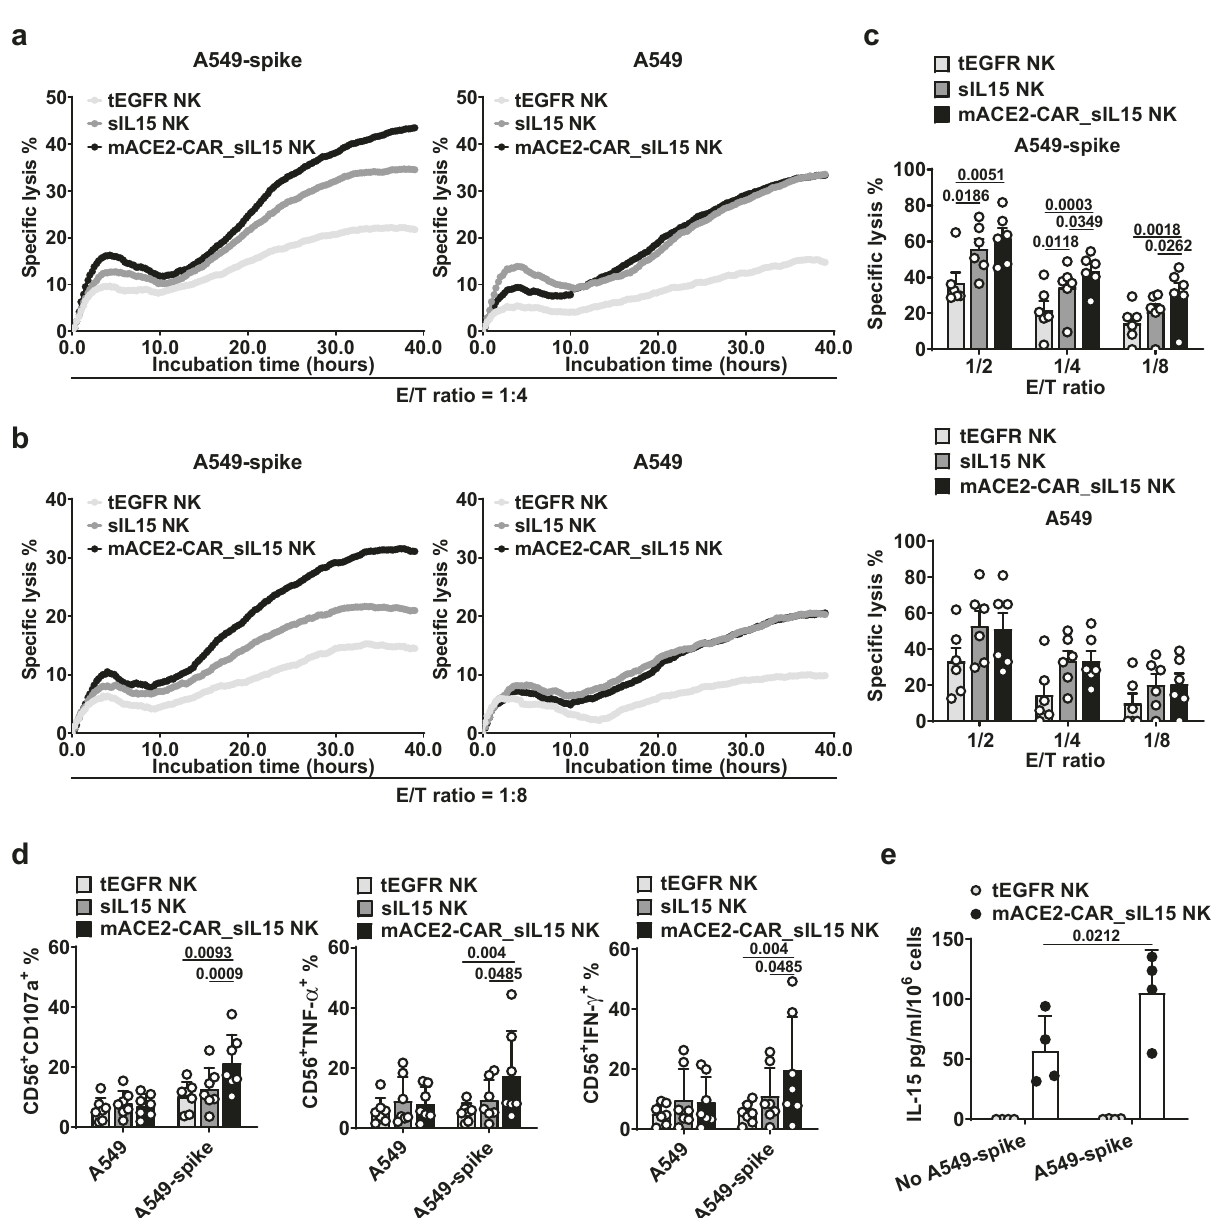
Fig. 3 mACE2-CAR_sIL15 enhances NK cell cytotoxicity against target cells that express SARS-CoV-2 spike protein. a Representative real-time cell analysis (RTCA) data showing NK cell cytotoxicity against A549-spike or parental A549 cells at an effector (E)/target (T) ratio of 1:4. b RTCA data showing NK cell cytotoxicity against A549-spike or parental A549 cells at an E/T ratio of 1:8. c Data from the RTCA assay analyzed at three different E/T ratios are summarized for cells from 6 donors. P values were determined with one-way ANOVA with multiple comparisons and adjusted by the Hochberg method. Data are presented as mean ± SEM. d Expression of CD107a, TNF- α , and IFN- γ was measured on transduced NK cells co-cultured with A549- spike or parental A549 cells for 4 h at an E/T ratio of 4:1. Data are summarized for NK cells from 7 donors. P values were determined by one-way ANOVA with multiple comparisons and adjusted by the Holm-Sidak or Dunn ’ s method. Data are presented as mean ± SD. e IL-15 production by ex vivo-expanded control tEGFR NK cells or mACE2-CAR_sIL15 NK cells cultured in the presence or absence of A549-spike cells for 72 h. Data are summarized for NK cells from four donors. P values were determined by one-way ANOVA with multiple comparisons and adjusted by the Holm – Sidak method. Data are presented as mean ± SD. Source data are provided as a Source Data fi